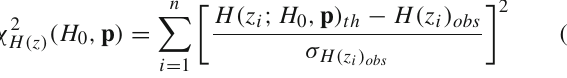
6 points come from the BAO peak position as a standard ruler in the radial direction [31–34]. Because the H ( z ) data come from two different techniques, and moreover one of the BAO points – the one at the highest redshift [34] – was obtained in a different way than other BAO data (from the Ly α forest) we also divided our data set (full n = 36 sample) into sub- samples: n = 35 points – high z BAO excluded, n = 30